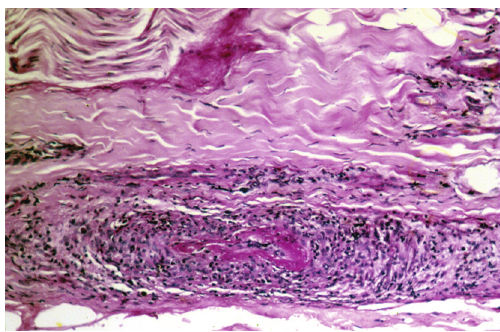
Figure 1: (Case 4). Medium diameter epineural artery. A promi- nent lymphocytic inflammatory infiltrate is present in the thickened vessel wall, with fibrinoid material causing luminal obstruction. H&E,